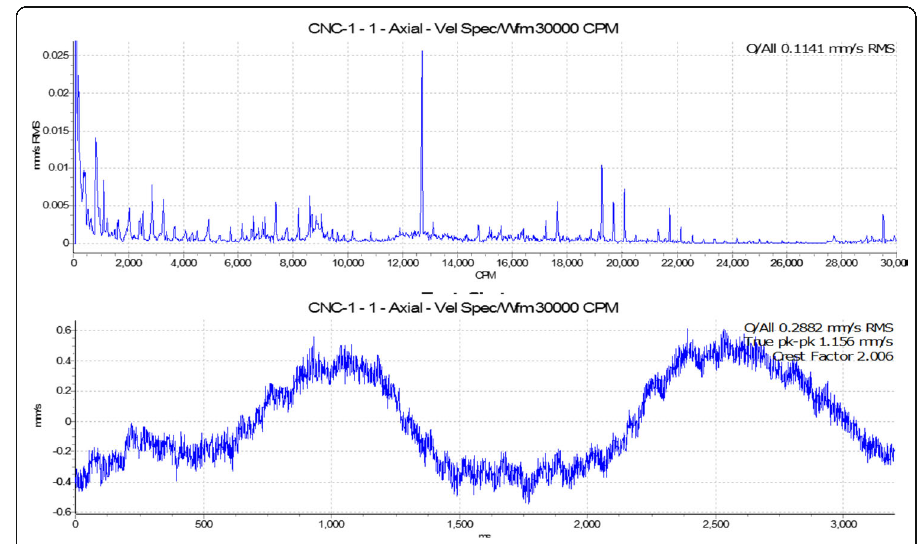
Fig. 2 Test condition (TC1) for tool